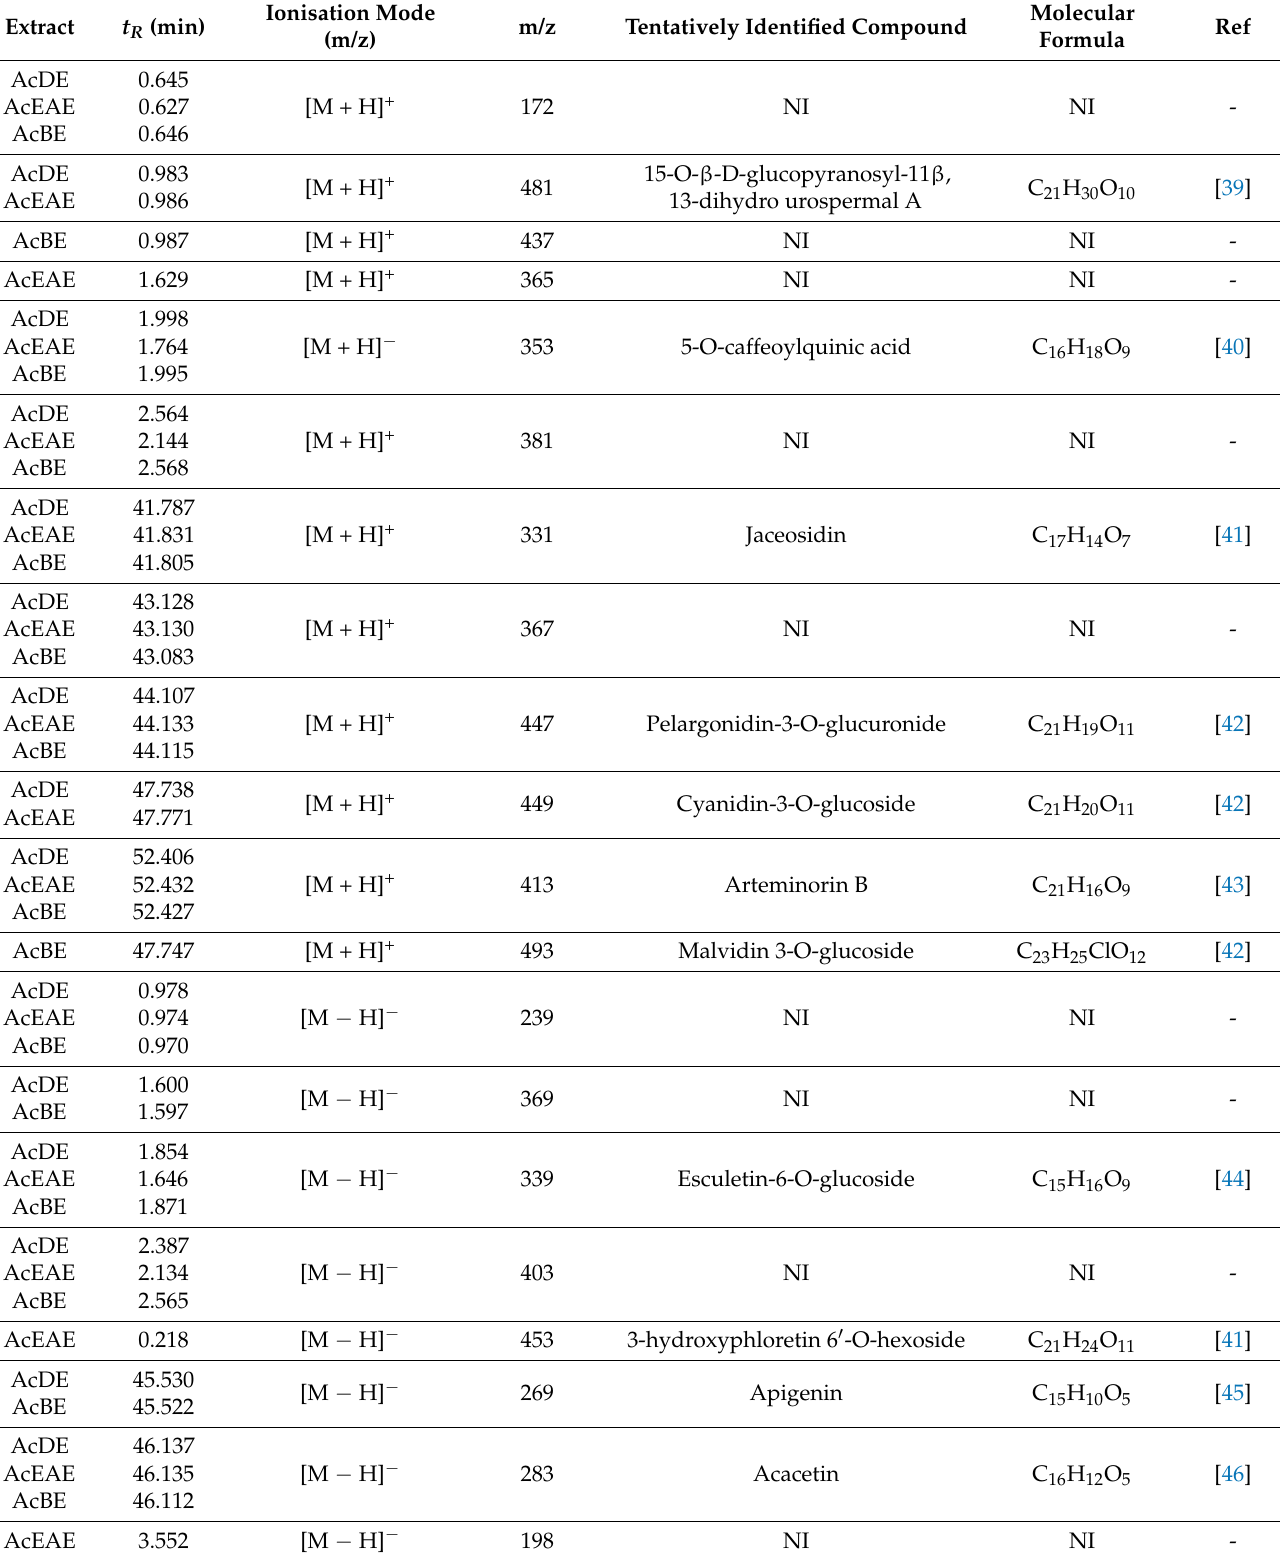
Table 3. Phenolic profile determined by LC-MS-MS in fractions from A. campetris compared with literature (retention time (Rt), not identifie